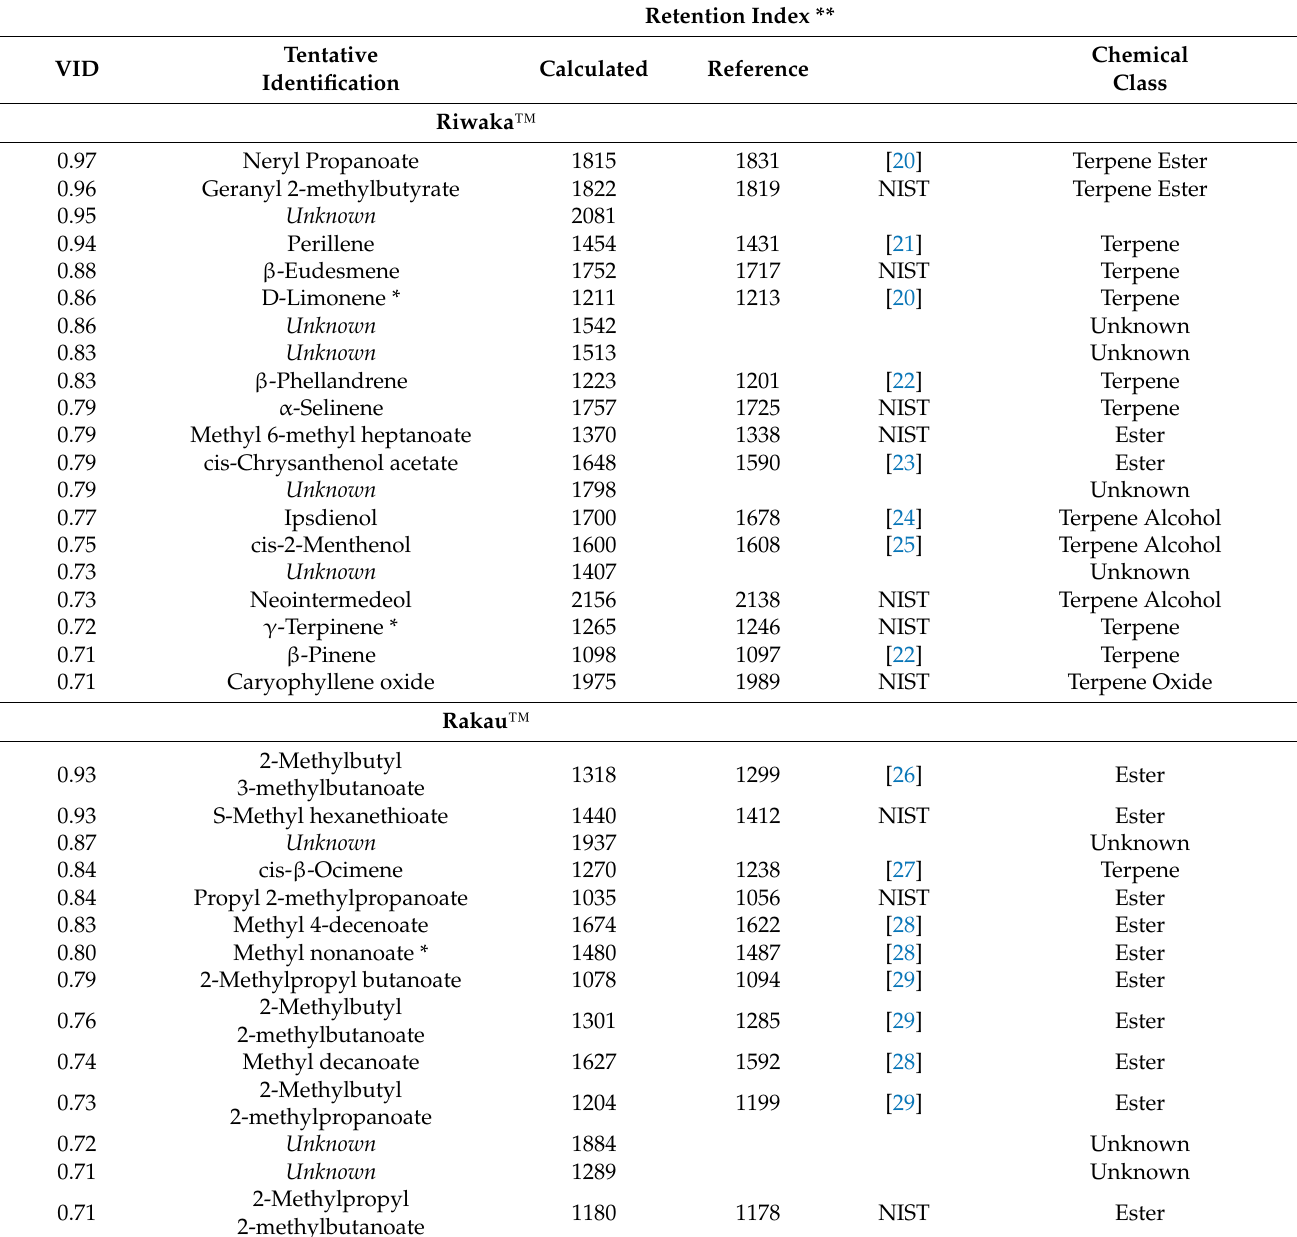
Table 1. Discriminant volatile compounds, selected per hop cultivar based on the variable identification (VID)